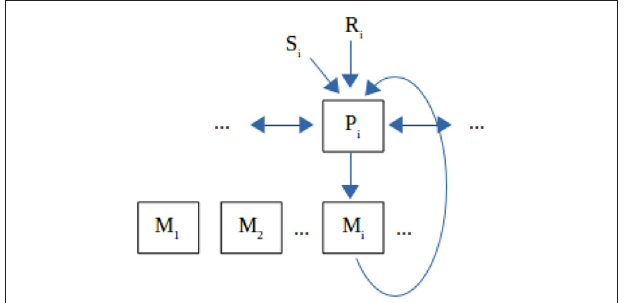
FIGURE 1 | Functional organization of the imitation system. (1) Affinity. A signal S i is initially perceived as a sensory pattern by a perceptual neural component P i that elicits an originally random motor response M j , whose output can also be perceived by the same system. If responses that have a communicative value are selected by the environment (like for example a phonetic response from M i matching the phonetic input S i , such as an “a” pronounced by self being perceived as an “a” pronounced by another) or if there appear P i ’s that happen to match S i and M i output, then evolution will favor the emergence of the pathways of the type P i -M i , where the output of M i is perceived by P i as the closest to S i among all M j . The pathway will show as higher population mass with larger total activation volume and diversity within the population, thus corresponding to our model of a “highly reproducing eigen-response.” (2) Self-organization . None of P i , M i are born as invariants. All of them are subject to continuous reorganization, where P i strives to better discriminate and assimilate (the closest) S i , M i strives to co-stabilize with P i , etc. Moreover, there will be lateral interactions between P i ’s and between M i ’s because in principle P i ’s overlap neurally to a degree, and so do M i ’s. Thus, it takes some self-organization effort for each of them to stabilize to a discrete functional role in the system interfering the least with the other components. Again, with all these in place, evolution will favor the emergence of initial (“innate”) structures that can self-organize correctly and with little effort given consistent stimulation. Exploration is the process by which P i ’s and M i ’s change intrinsically. (3) Higher-level association. External signals are not just reproduced by the motor system, but they also refer to external objects (S i refers to R i ). Association of S i ’s with R i ’s will again pass through the organism’s perceptual system ( via a similar system as the previous level, but abstractly shown in the figure), so that either of them can finally trigger the same response M i . We note that this is a minimal mirroring property, but insufficient to produce “intention understanding” or anything cognitively more advanced. Structurally (meaning) association is a process parallel to the previous ones and the correct associations could emerge independently of whether the proper P i -M i pathways have been built. But they are much easier to